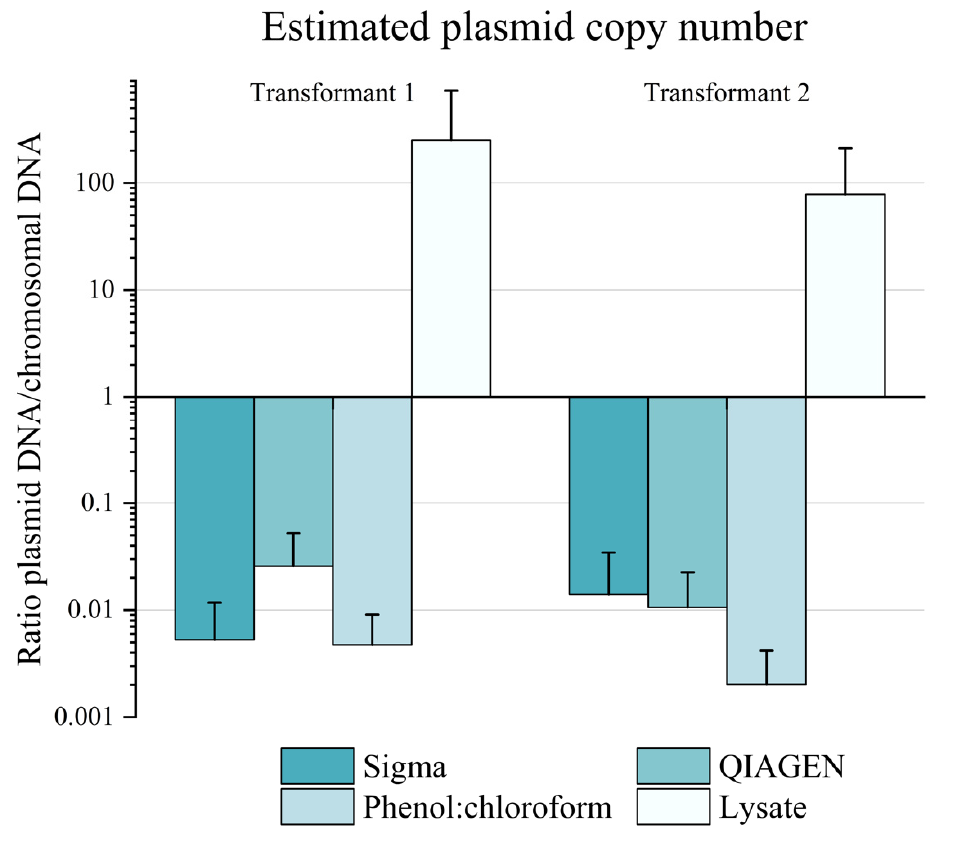
Figure 3. Estimated plasmid copy numbers using qPCR-measured fluorescence. Three genomic DNA (gDNA) extraction methods were explored and compared to boiled crude lysates, highlighting that gDNA might not be an appropriate template for qPCR, as previously observed. Error bars represent standard deviation ( n =